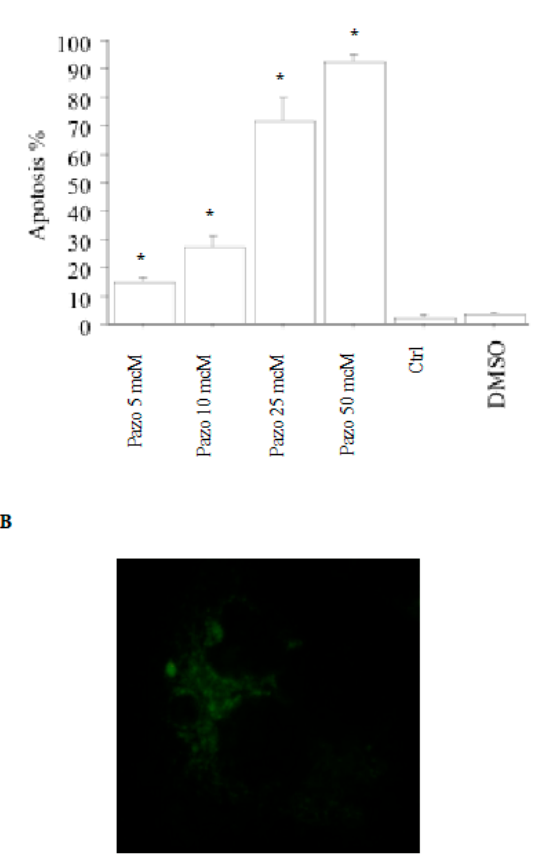
Figure 3. Apoptosis assays in pATC cells. ( A ) pATC cell apoptosis after treatment with pazopanib or with its vehicle (dimethyl sulfoxide) alone for 24 h (by Hoechst 33342). A significant dose-dependent increase in the percentage of apoptotic cells was observed with pazopanib. Data are shown as the mean ± SD, and they were analyzed by one-way ANOVA (with Newman–Keuls multiple comparisons test and a linear trend test) (* p < 0.001 vs. control). ( B ) pATC cell apoptosis after treatment with pazopanib 50 µ M for 24 h (Annexin V